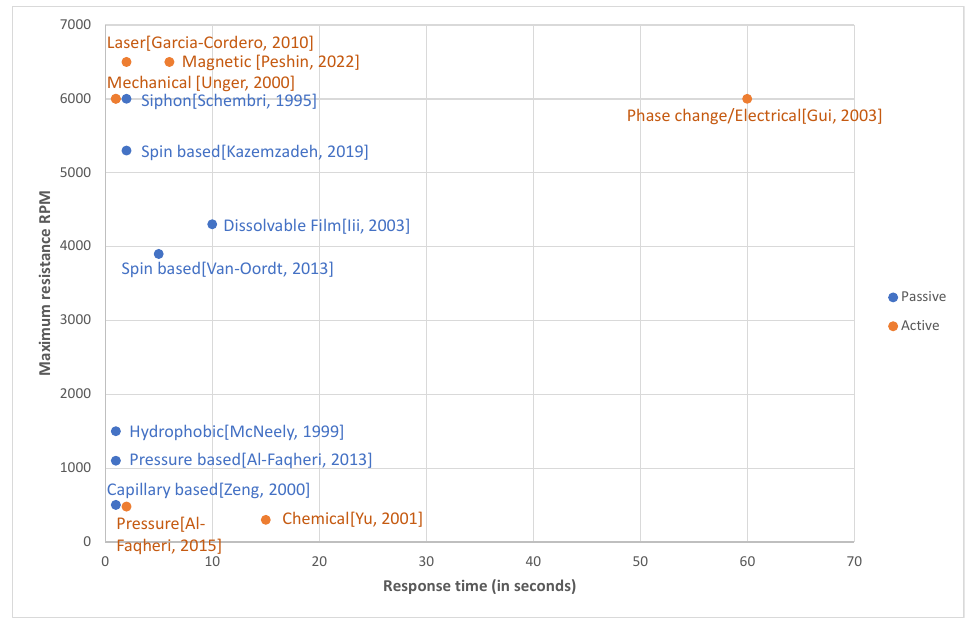
Figure 18. The various types of active and passive valves plotted on the axis of response time (in seconds) versus the maximum CD spin rate (in RPM) that the valves are able to withstand before bursting. The location of the valve to calculate the resistance RPM is 20 mm from the center of a disc that had a diameter of 80 mm [11,25,30,33,34,38,41,44,45,56,60,68,71].